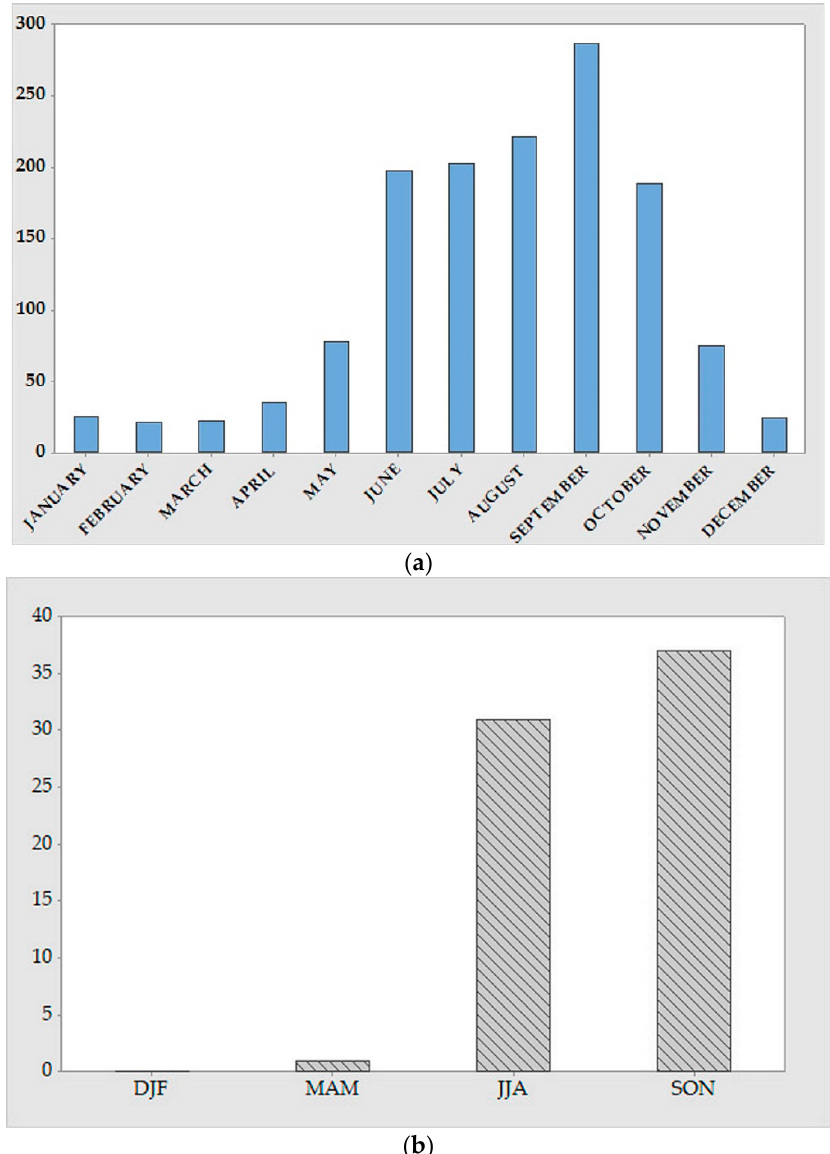
Figure 3. ( a ) Monthly mean rainfall (mm mo − 1 ) over VCZ detonated by the square in Figure 5, during 1998–2015 using CMORPH precipitation data (3-h and 0.25° resolution temporal and spatial, respectively). ( b ) The estimated contribution of TCs to mean seasonal rainfall (mm mo − 1 ) using global rain gauges data between 1970 and 2014 and modified from Khouakhi et al. [39]. December–January– February (DJF), March–April–May (MAM), June–July–August (JJA), and September–October– November (SON).